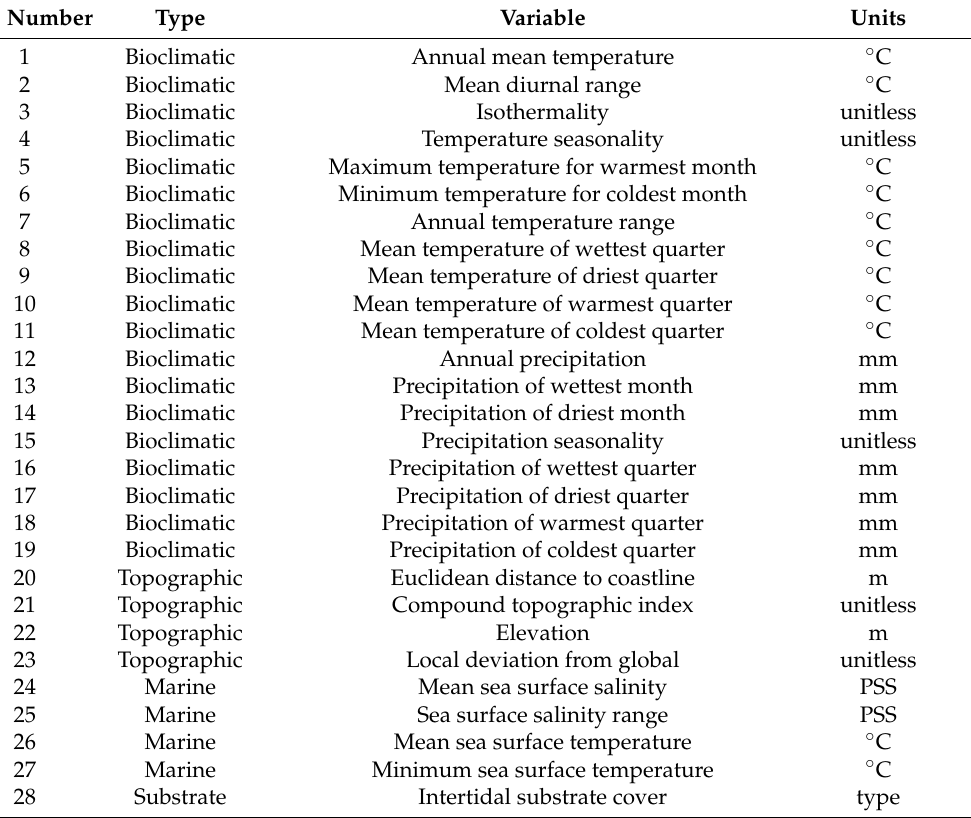
Table 1. Environmental factors used to predict current and future suitable habitats for mangroves in Fujian